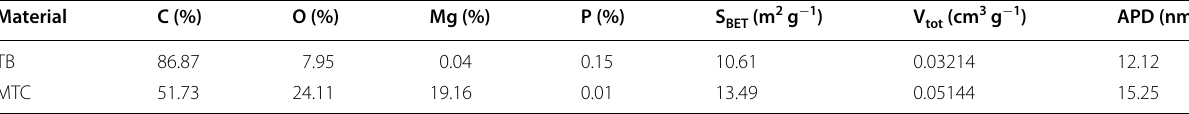
Table 1 Elemental composition of TB and MTC samples